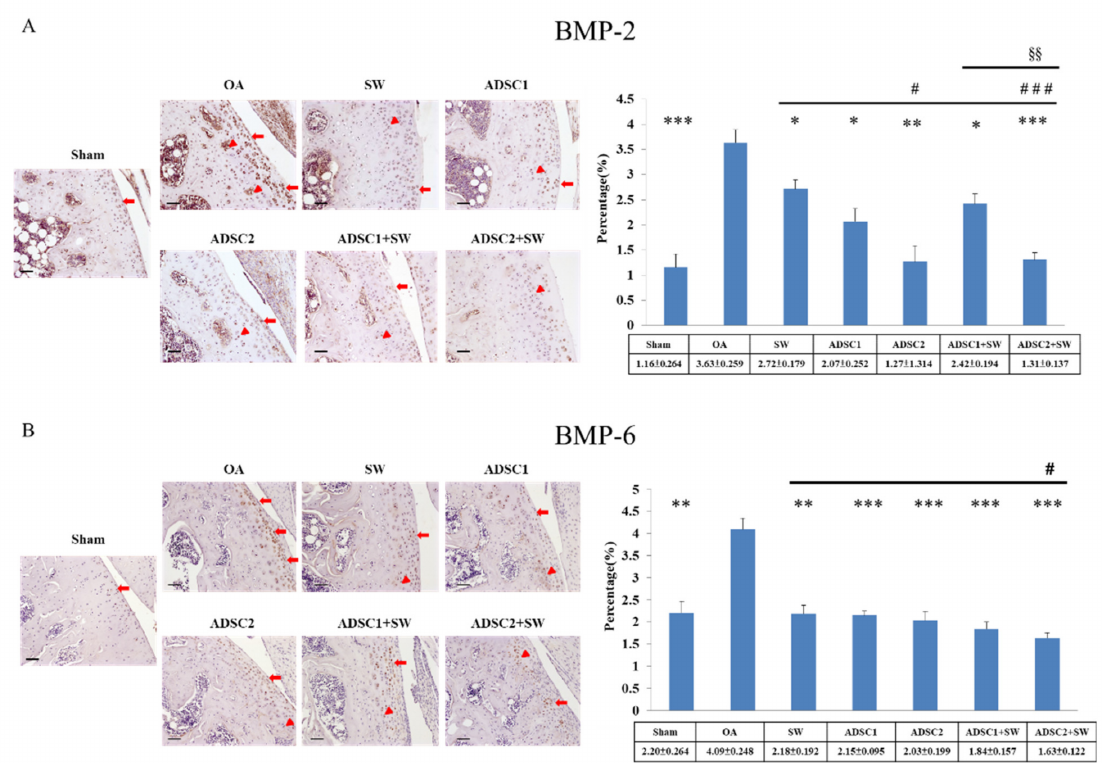
Figure 5. The levels of inflammation-induced BMP-2 and BMP-6 in the articular cartilage of OA rat knee after treatment. ( A ) BMP-2 and ( B ) BMP-6 as measured by immunohistochemical staining in the articular cartilage of the tibia after treatment. The expression percentages were shown on the left of the images. * p < 0.05, ** p < 0.01, and *** p < 0.001 as compared with the OA group. # p < 0.05 and ### p < 0.001 as compared with the SW group. §§ p < 0.01 as compared with the ADSC1 + SW and ADSC2 + SW groups. The images were shown at 200 × magnification. The scale bar was 50 µ m. The triangle was indicated deep region, and the arrowhead was indicated cartilage surface. n = 6 rats in each